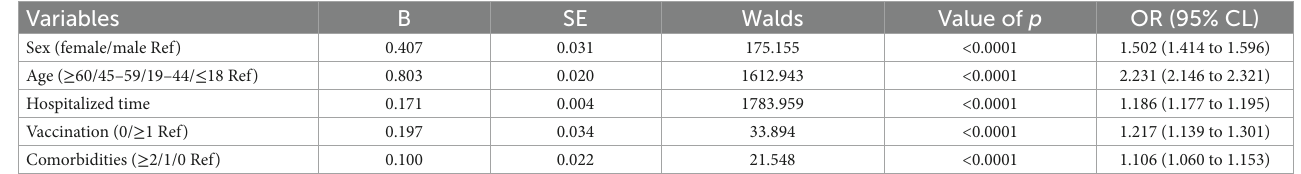
TABLE 3 Multivariate logistic regression analysis of risk factors influencing psychiatric drug